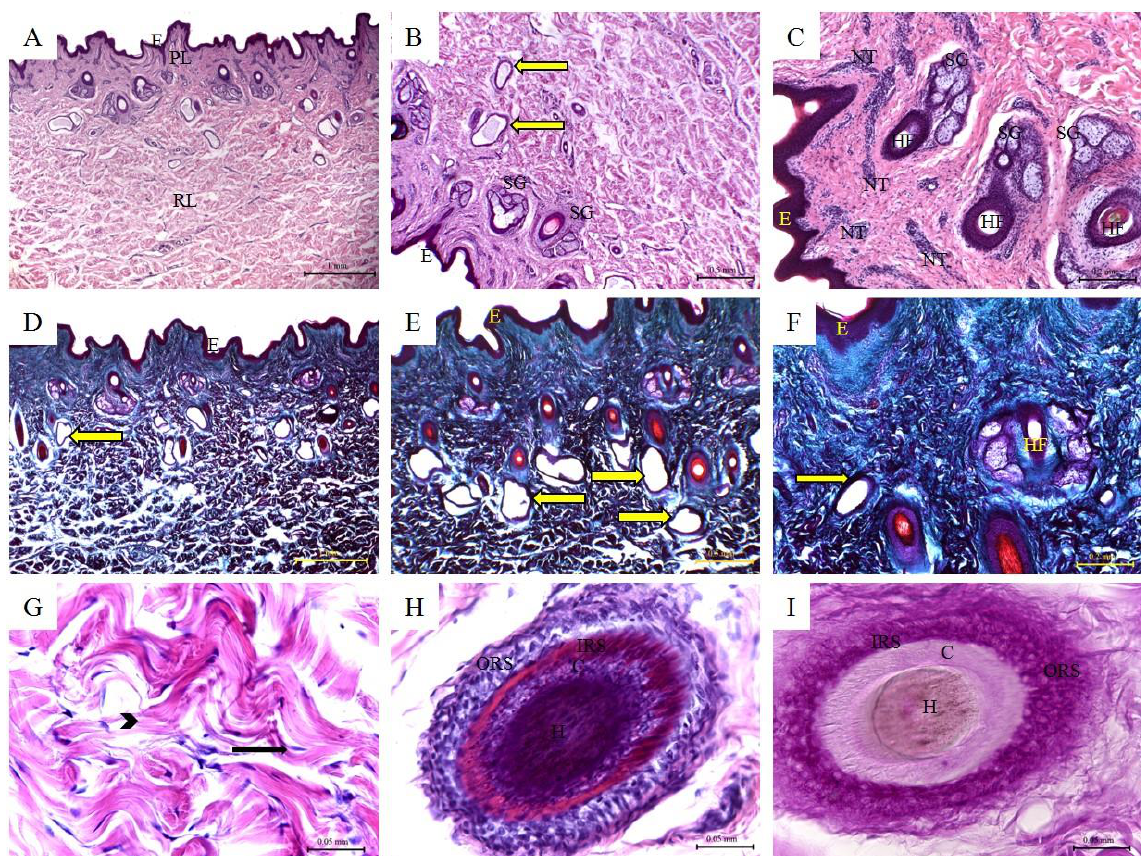
Figure 1: Histological features of buffalo skin. Hematoxylin and eosin staining ( A-C ; G-H) ; Cross- man's trichrome staining ( D-F) ; and PAS staining ( I ) of buffalo skin tissue sections. (E) Keratinized stratified squamous epithelium of the epidermis; (PL) Papillary layer of the dermis; (RL) Reticular layer of the dermis; (NT) Nerve tissue; (SG) Sebaceous glands; (Black arrow) fibrocytes; (Ar- row heads) collagen bundles of the reticular layer; (Yellow arrow) Sweat glands; (HF) Hair follicles; (H) Hair; (C) Cuticle; (IRS) Inner root sheath; (ORS) Outer root